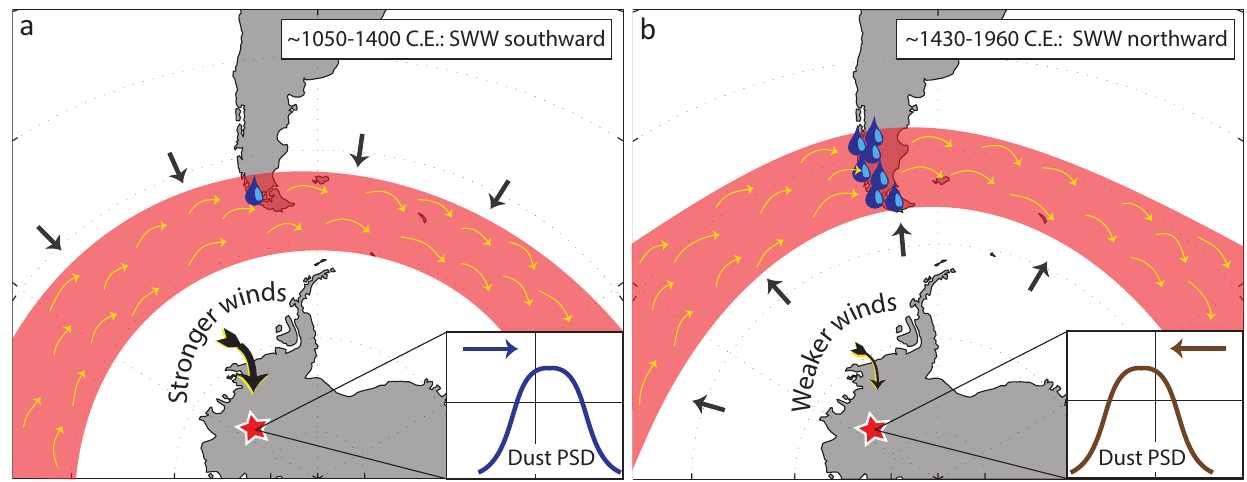
Figure 9. Schematic diagram showing interpretation of paleoclimate records. (a) During the interval 1050–1400CE, the SWW are shifted southward, reducing precipitation in the SH mid-latitudes and driving greater cyclogenesis in the Amundsen–Bellingshausen Sea region; stronger winds in turn carry dust with a coarser particle size distribution (PSD). (b) From ∼ 1430–1960CE, the SWW occupy a more northerly position, enhancing precipitation in the SH mid-latitudes and reducing cyclogenesis and wind speed in the WAIS Divide region; weaker winds in turn transport dust with a finer